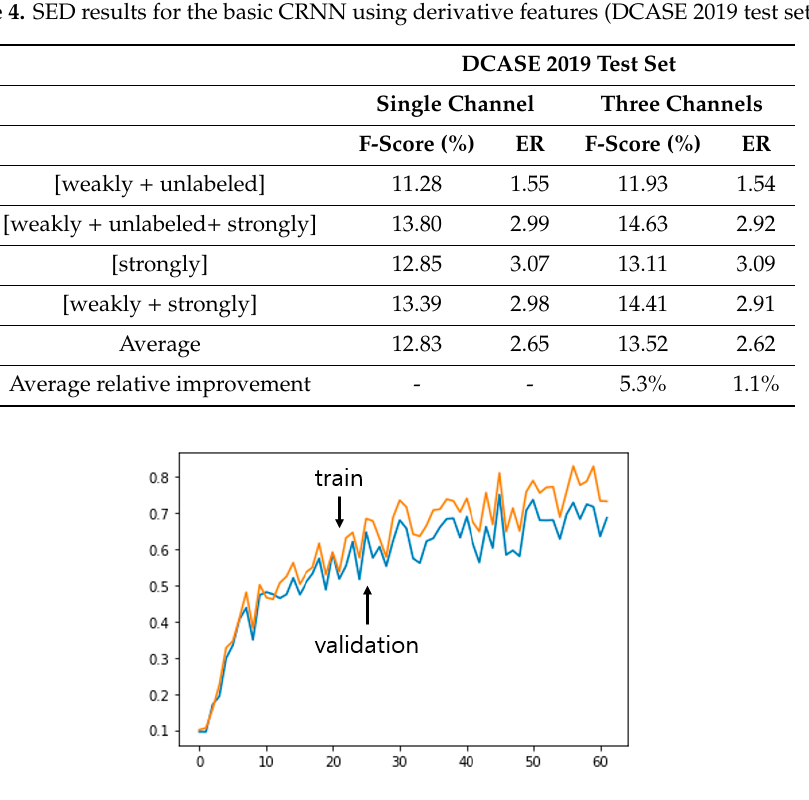
Figure 5. Learning curve in F-score of the basic CRNN with weakly labeled training data.